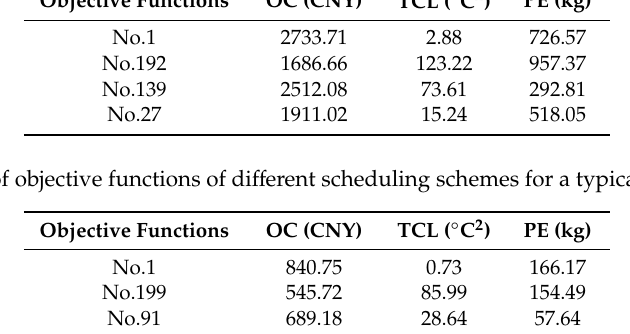
Figure 13. The optimal scheduling results for RR-microgrid with CHCS. ( a ) A typical day in winter; and ( b ) a typical day in summer. Table 13. Value of objective functions of different scheduling schemes for a typical day in winter. Objective Functions